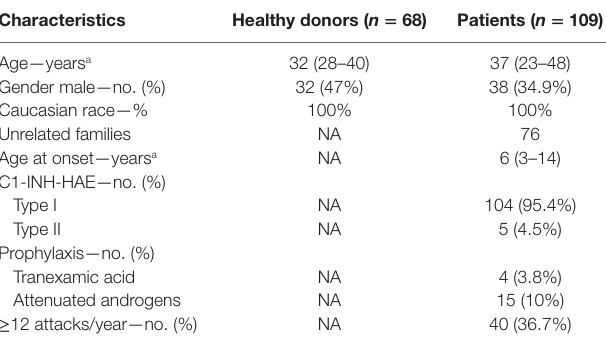
TaBle 1 | Characteristics of 109 patients with C1-INH-HAE and 68 healthy donor